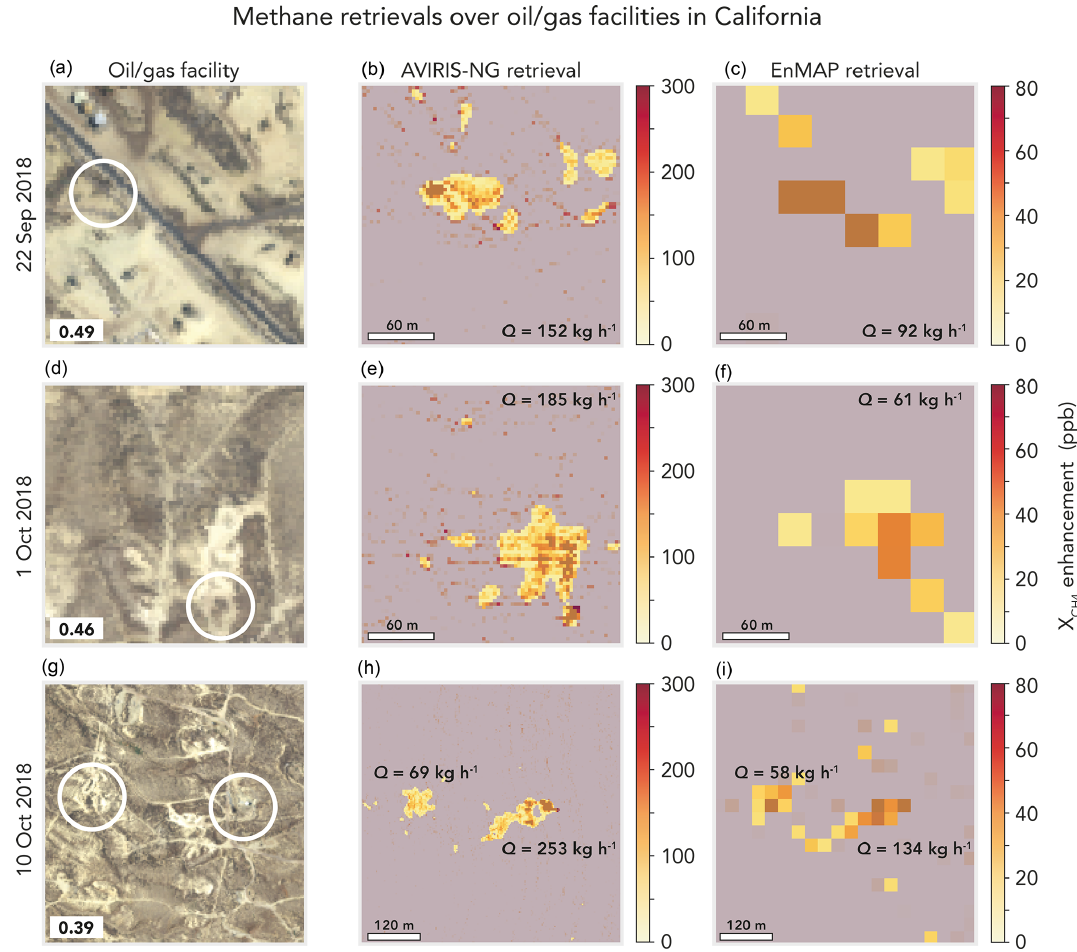
Figure 7. Retrieval of atmospheric methane plumes from facilities in the San Joaquin Valley of California imaged by the AVIRIS-NG instrument at 3–4km altitude (CARB, 2017). (a) , (d) , and (g) show the RGB images mapped by AVIRIS-NG with the oil/gas facilities of interest circled. Inset in the bottom left corner is the mean retrieved SWIR surface reflectivity for the scene. (b) , (e) , and (h) show the IMAP-DOAS retrieval applied to the AVIRIS-NG images with 3m × 3m pixel resolution and 5nm spectral resolution. (c) , (f) , and (i) show the IMAP-DOAS retrieval applied to spectra that were spatially and spectrally downsampled to match EnMAP instrument specifications (30m × 30m pixels, 10nm spectral resolution). Note the difference in color scale for the methane enhancements in the AVIRIS-NG and EnMAP retrievals, reflecting the coarser pixel resolution of EnMAP. The plume mask described in the text is overlaid on each. The source rates for each plume obtained from the IME method are